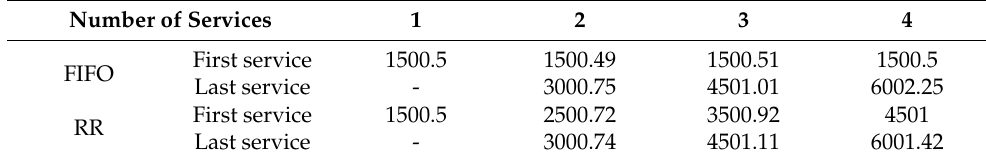
Table 3. Response times with double